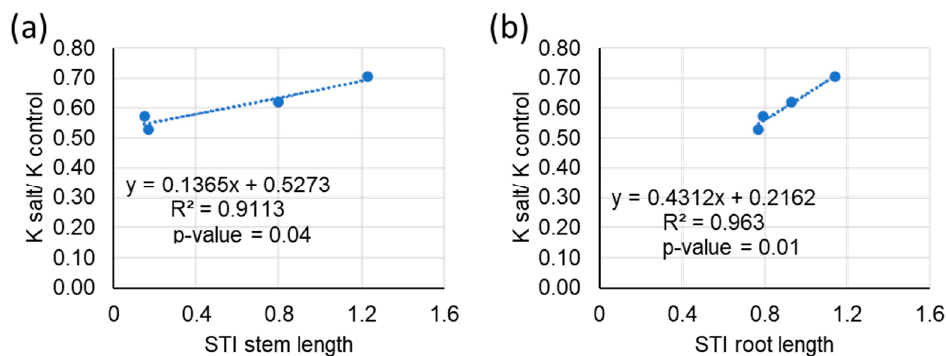
Figure 6. Relationship of leaf K-salinity/K-control with STI stem length, and STI root length. ( a ) Relationship between leaf K-salinity/K-control and STI stem length. ( b ) Relationship between leaf K-salinity/K-control and STI root length.